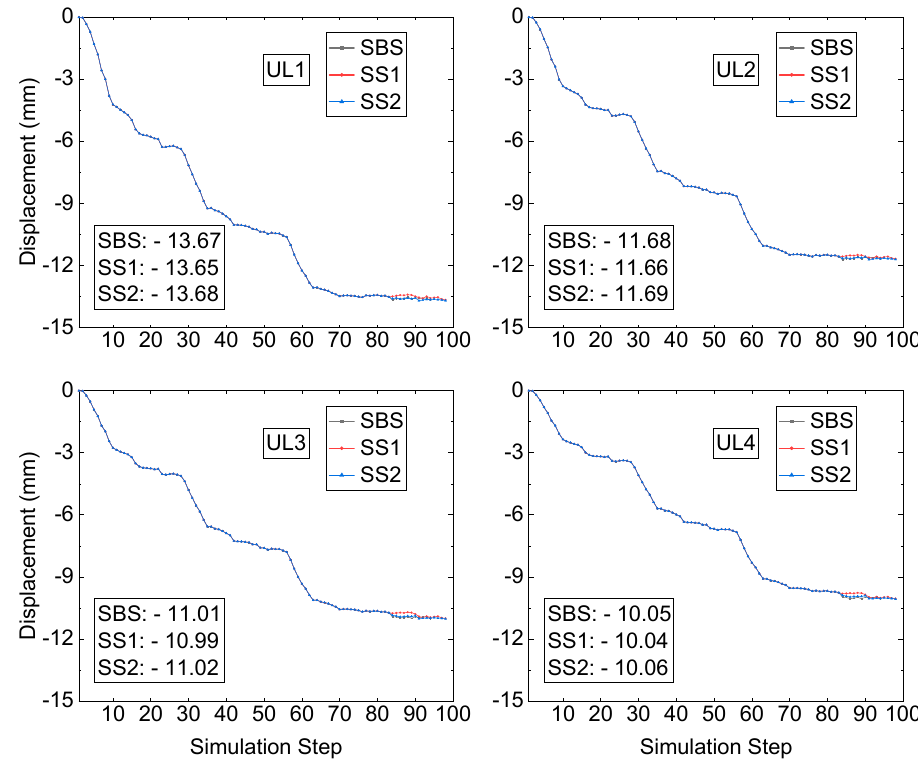
Figure 9. A displacement comparison at the monitored locations. Table 4. Sill pillar recovery induced displacement at upper levels.